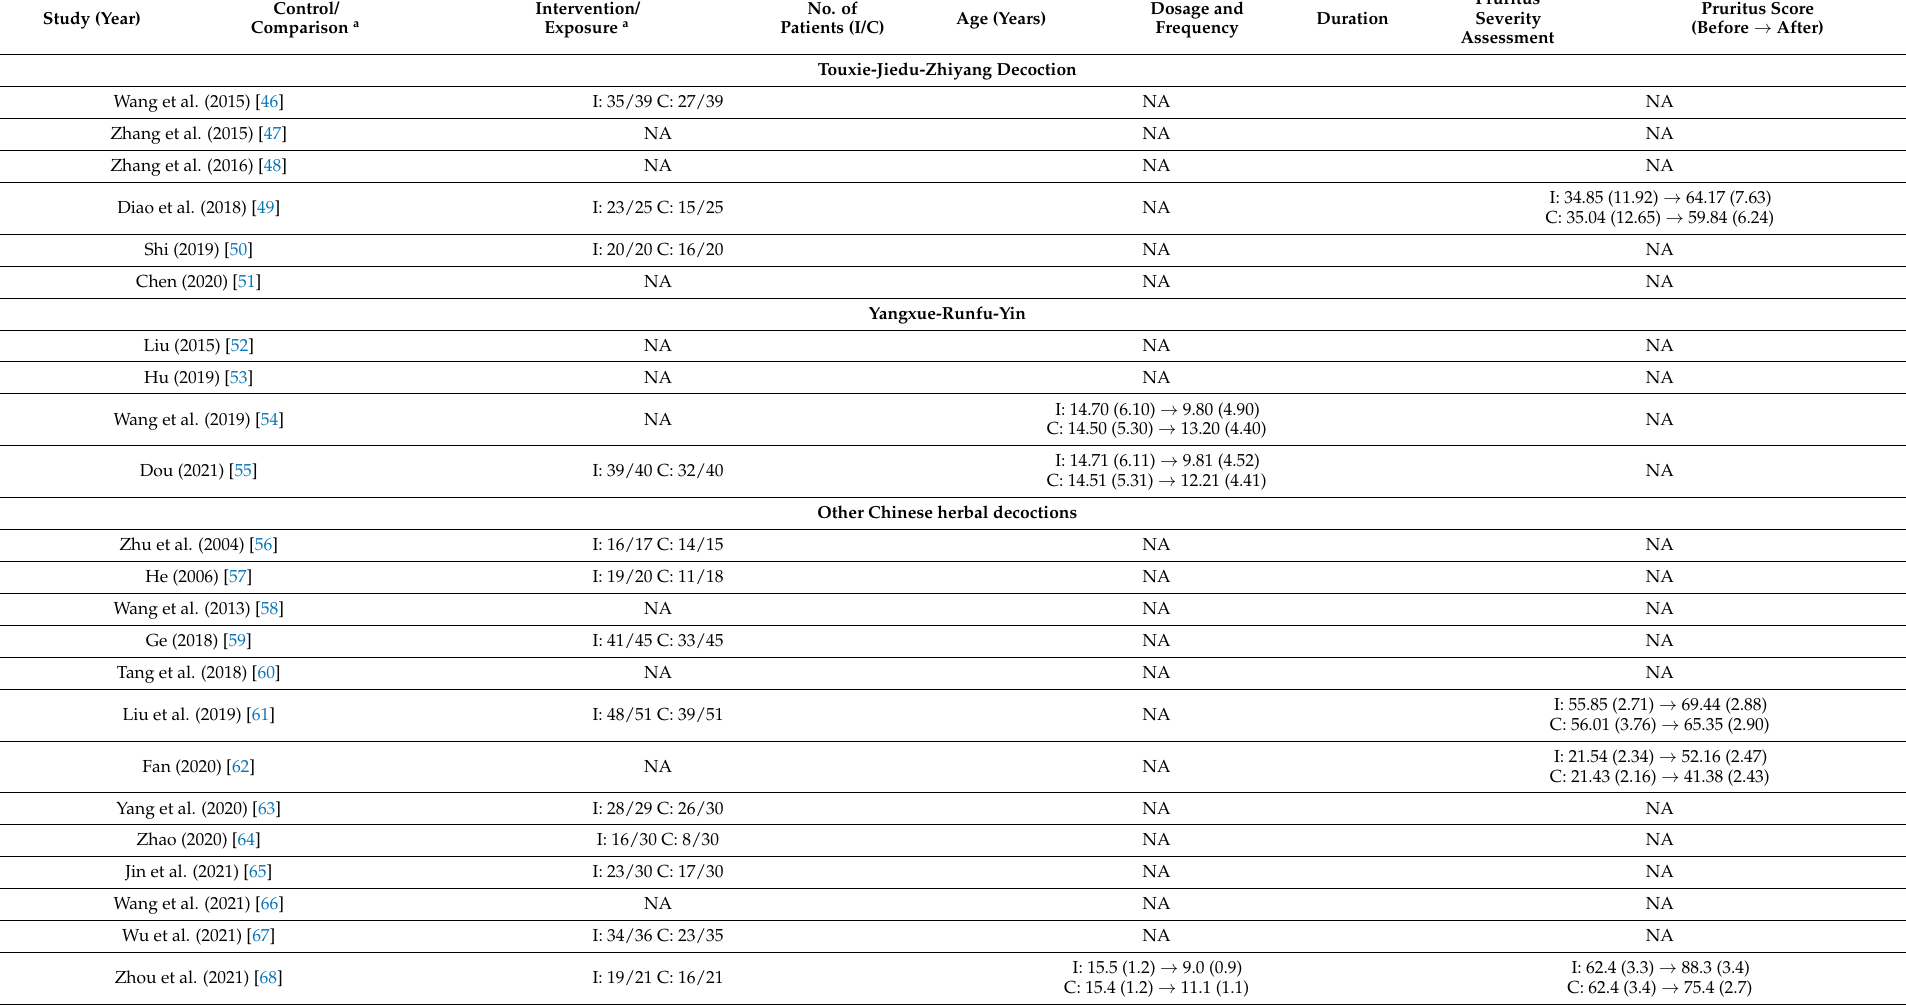
Dosage and Frequency Duration